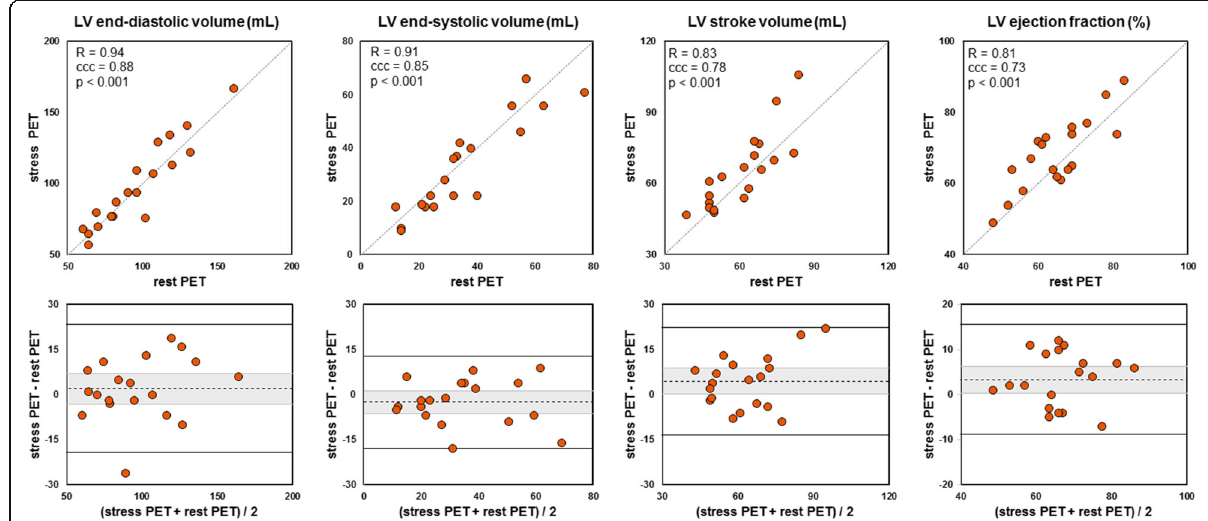
Fig. 1 Comparison between rest and stress left ventricular volumes and function. Top: scatter plots. The grey lines stand for the perfect identity ( R , Pearson ’ s correlation; ccc, Lin ’ s concordance correlation coefficient). Bottom: Bland-Altman diagrams. The dashed lines indicate the mean difference (greyed is the 95% confidence interval) and the plain lines the 95% limits of agreement